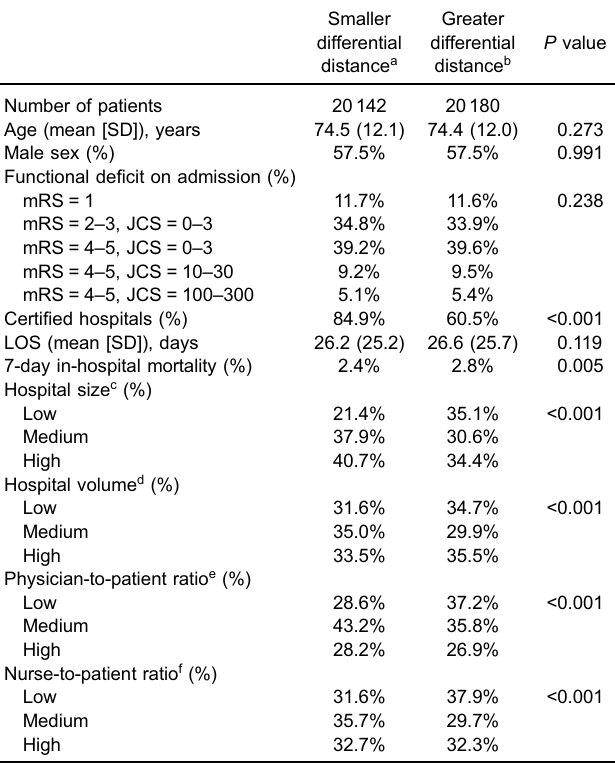
Table 2. Patient characteristics by differential distance Table 3. Results of single probit and bivariate probit model on 7-day in-hospital